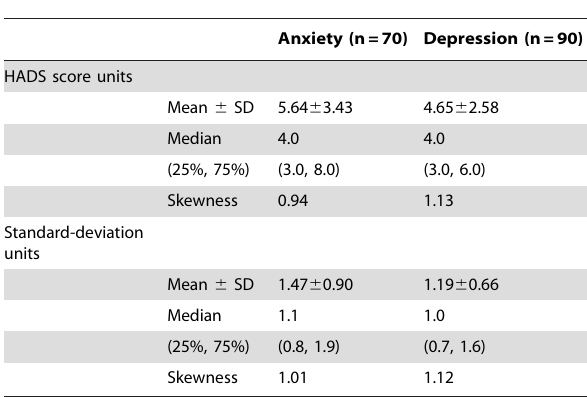
Table 6. Magnitude of decay of